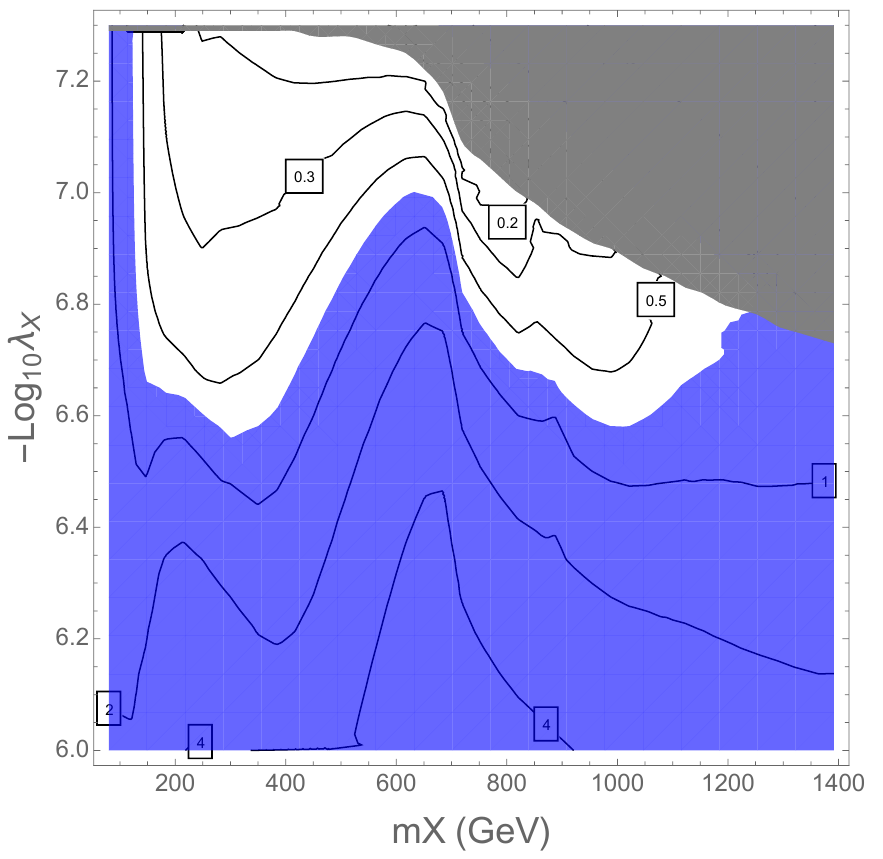
Figure 10 . Parameter space where thermal production of X gives a large enough relic abundance to dilute the twin sector, for f=v = 4. In the gray region, the coupling is too weak for X to ever reach thermal equilibrium. The blue region is in tension with recent Planck measurements of (cid:1) N e(cid:11) , whereas all of the white region will be tested by CMB-S4. Predictions presented here for (cid:1) N e(cid:11) close to the gray boundary are more uncertain because of the high sensitivity of the freeze-out temperatures to the